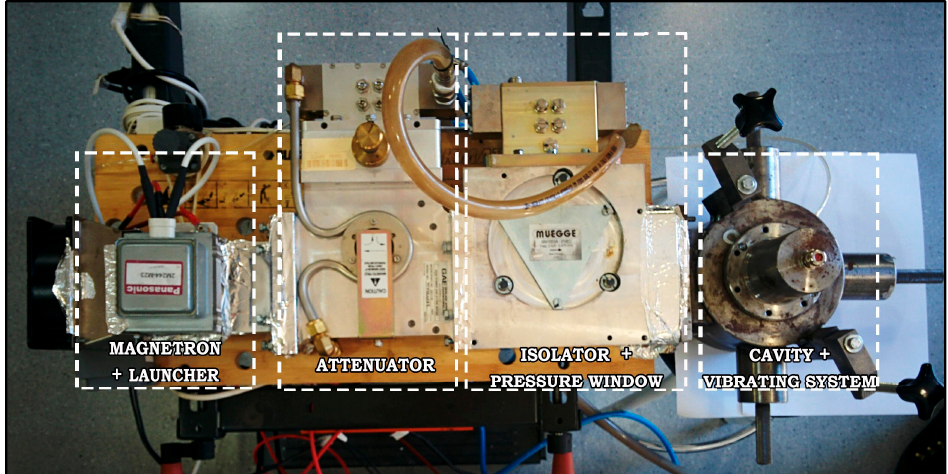
Figure 1. Experimental microwave single-mode cylindrical cavity prototype to obtain precise temperature profiles for sterilization purposes.